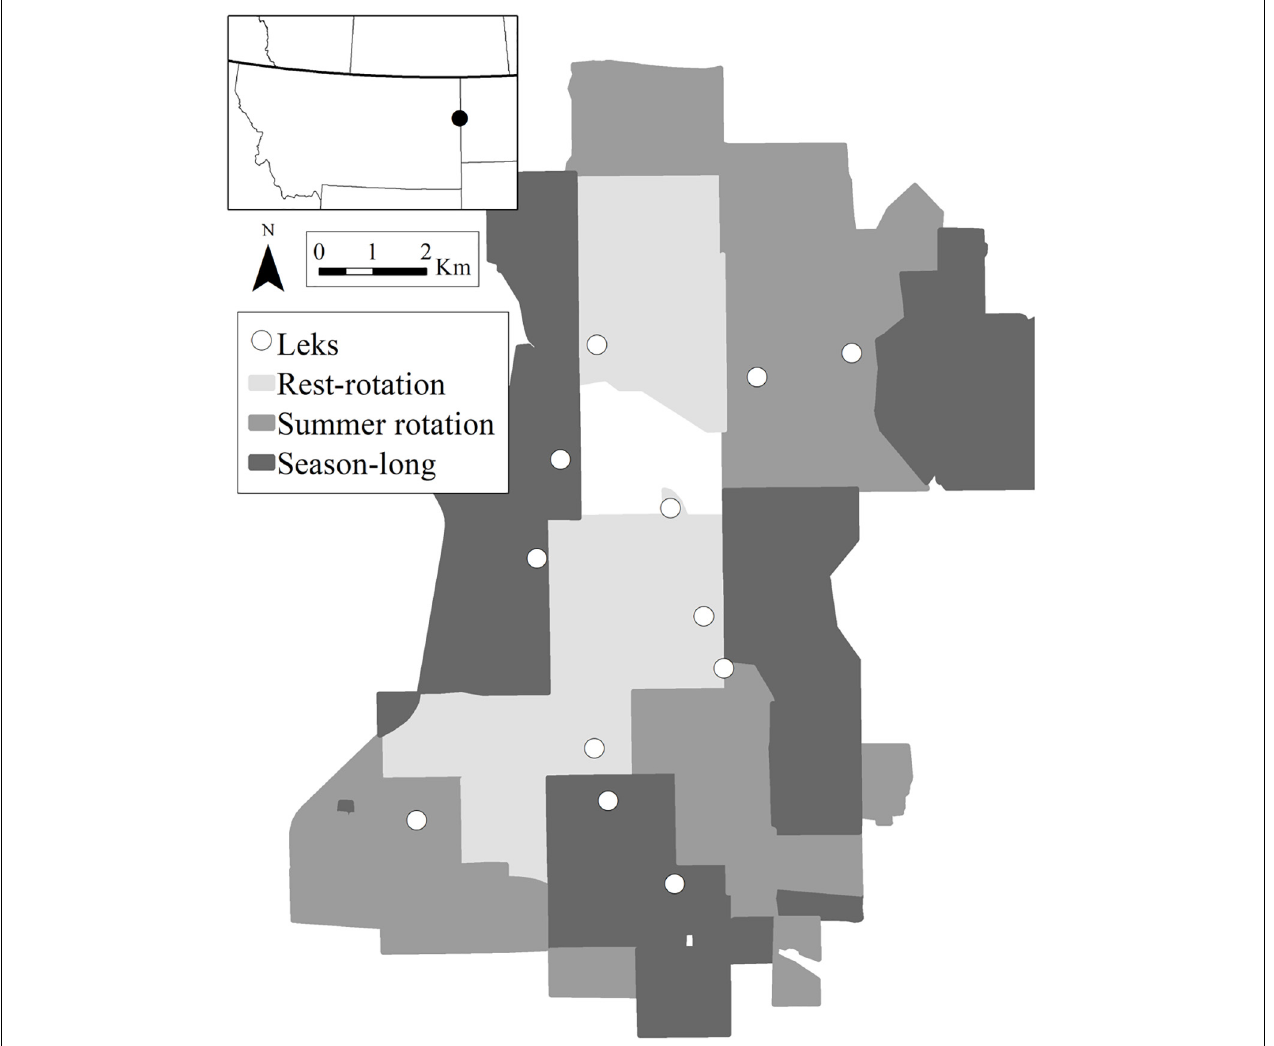
FIGURE 1 | Study area in eastern Montana and western North Dakota. Monitored leks where birds were captured are shown as white circles, with the three grazing systems shown for each pasture in gray.